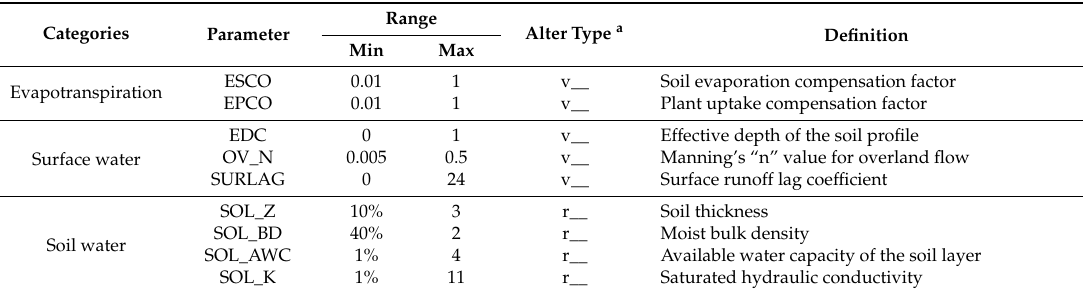
Table 2. Description of model parameters and their